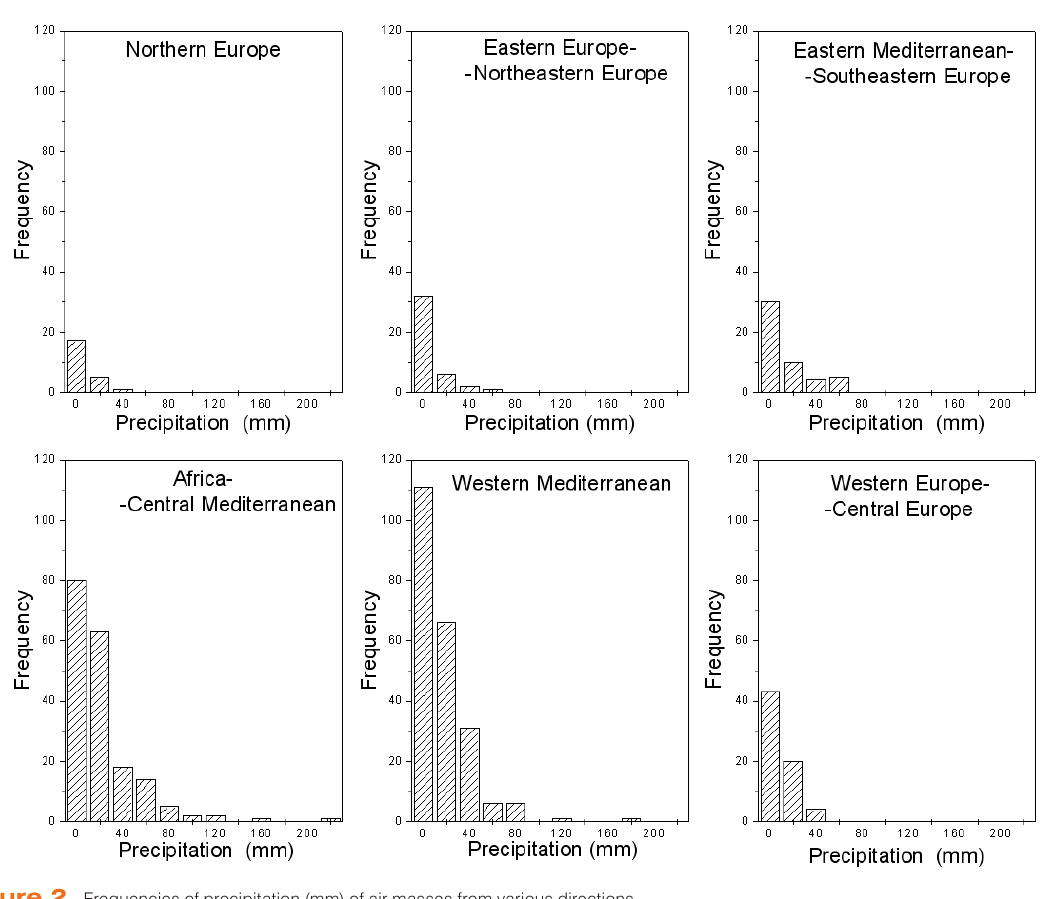
Figure 2. Frequencies of precipitation (mm) of air masses from various directions.